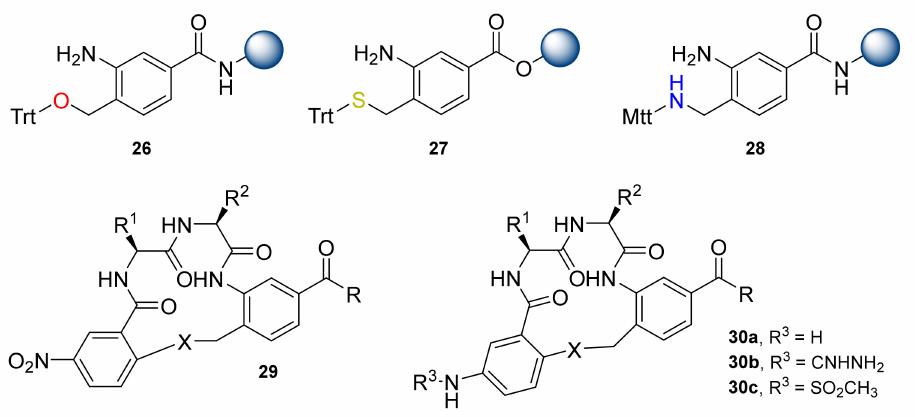
Figure 1. C 10 β -turn mimetics and resins for their synthesis. Golebowski et al. presented a series of diketopiperazine-based β -turn mimetics. The first report focused on diketopiperazine formation via a Petasis reaction (Scheme 6)